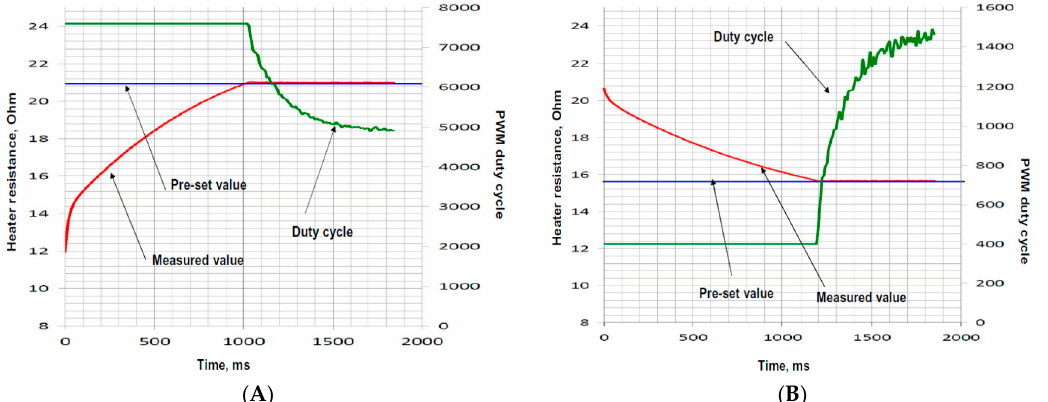
Figure 2. ( A ) Heating process of thick film gas sensor. Pre-set resistance corresponds to working temperature of 450 °C. 100% duty cycle of PWM corresponds to 8000 value at the right axis. τ 90 of the heating process is of ~0.8 s; ( B ) Cooling process of thick film gas sensor. Pre-set resistance corresponds to working temperature of ~200 °C. 100% duty cycle of PWM corresponds to 8000 value at the right axis. τ 90 of is ~1